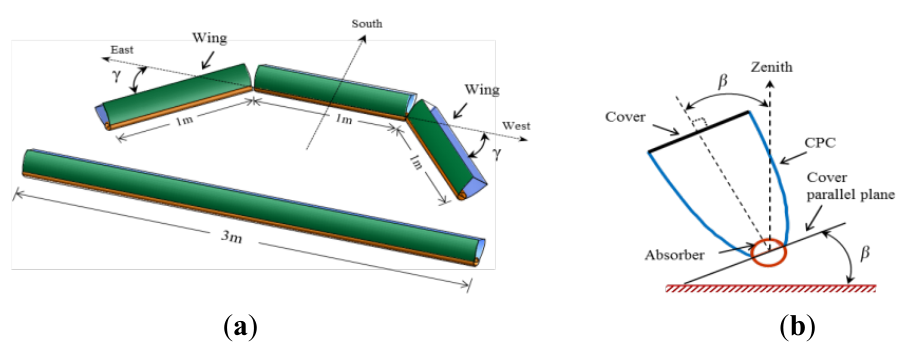
Figure 1. Description of the proposed CPC, ( a ) difference in shape between proposed CPC with angled wings (upside) and linear CPC (downside) and ( b ) CPC